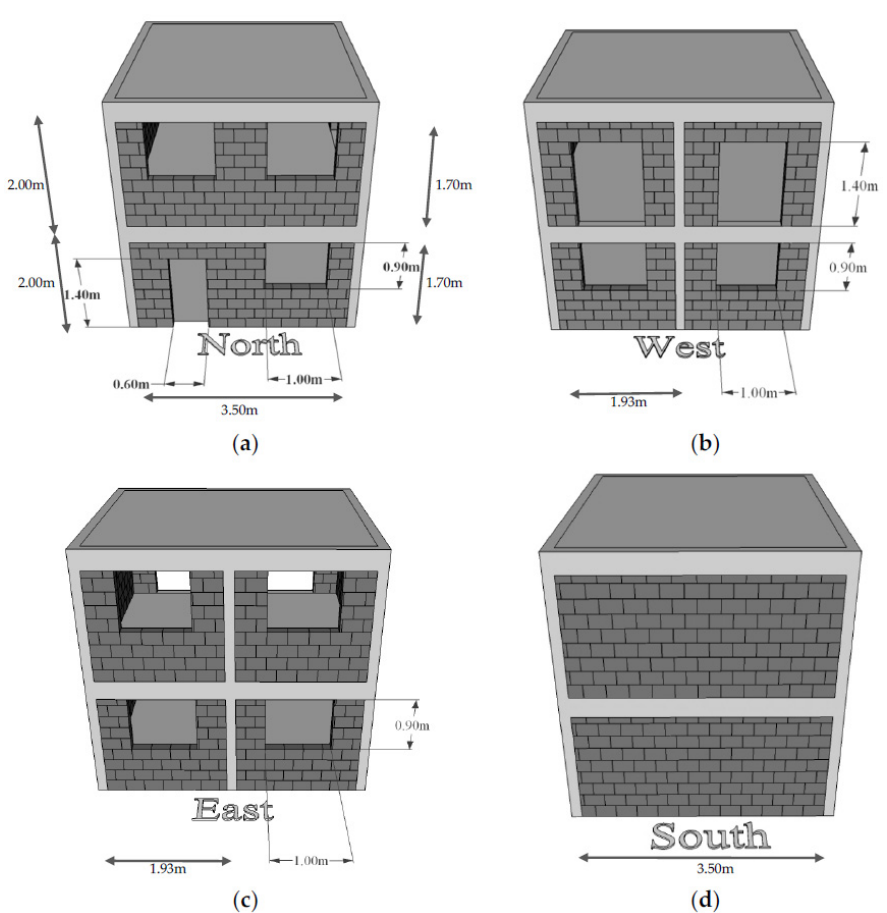
Figure 7. Geometry of the openings in each facade: ( a ) North; ( b ) West; ( c ) East; ( d ) South.